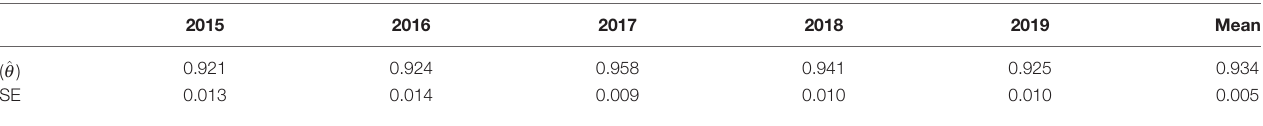
TABLE 3 | Mark-ratio ( ^ q ) for the DRE Indo-Paci fi c humpback dolphins.